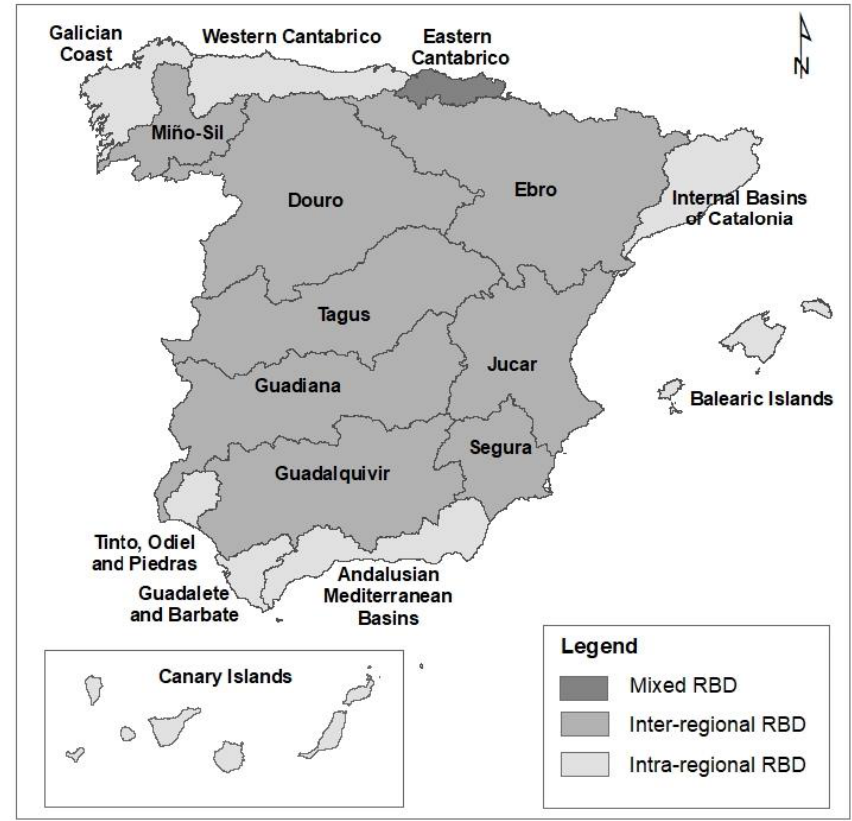
Figure 3. Spanish River Basin Districts. Table 2. Spanish River Basin Districts: DMPs